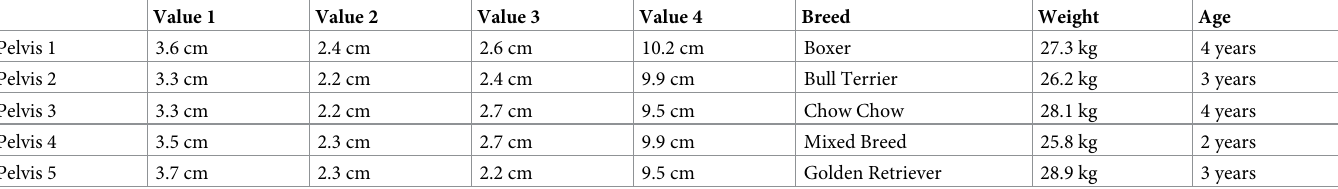
Table 1. Measures of cadaveric pelvic dog bones.